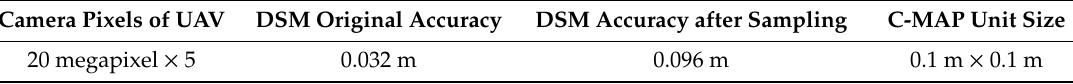
Table 1. Cartographic information.